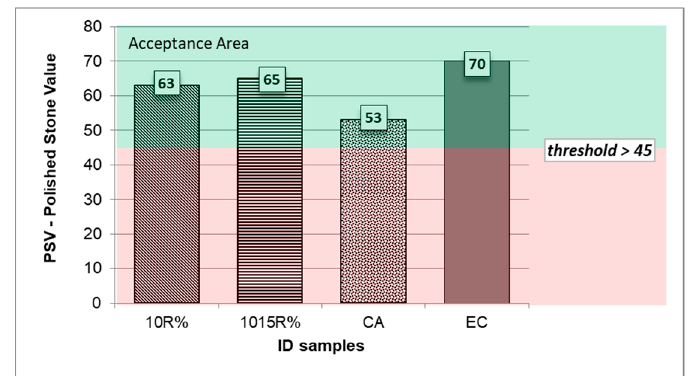
Figure 13. Histogram of average Polished Stone Values for samples 10%R, 1015%R and CA compared with PSVs of expanded clay and acceptance threshold values (green area) from common Italian technical specifications. (Note: in the figure PSVs are × 100.).